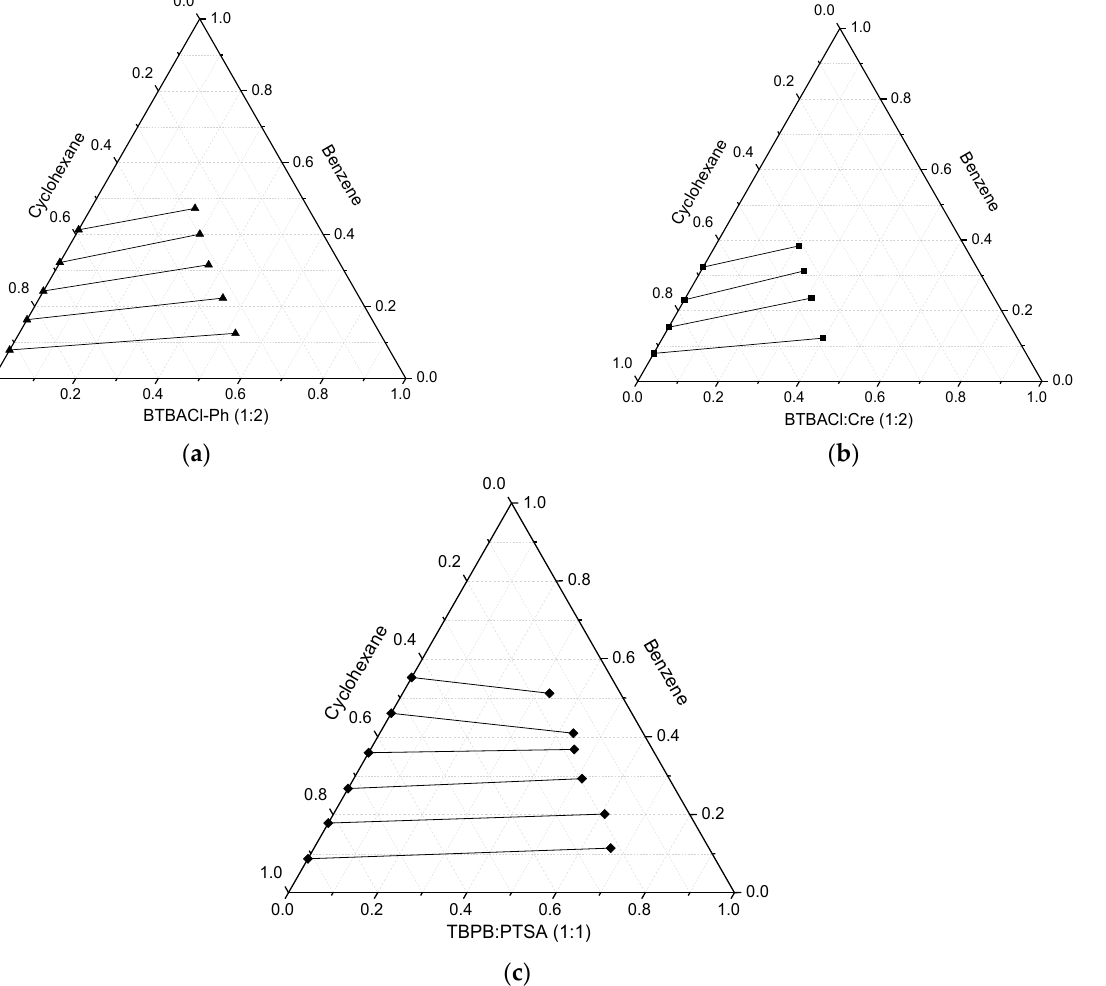
Figure 4. Ternary liquid–liquid equilibria diagrams for ( a ) BTBACl:Ph (1:2) + benzene + cyclohexane; ( b ) BTBACl:Cre (1:2) + benzene + cyclohexane and ( c ) TBPB:PTSA (1:1) + benzene + cyclohexane.